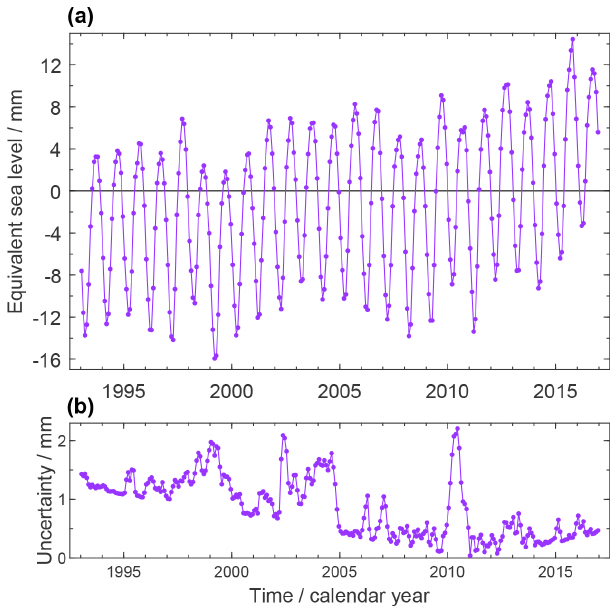
Figure 8. (a) Contributions from global land water storage changes (except for Greenland and Antarctica) to GMSL, assessed by the WaterGAP global hydrology model at its monthly resolution. Wa- ter mass change is expressed in terms of equivalent GMSL change with respect to the mean of the reference interval of